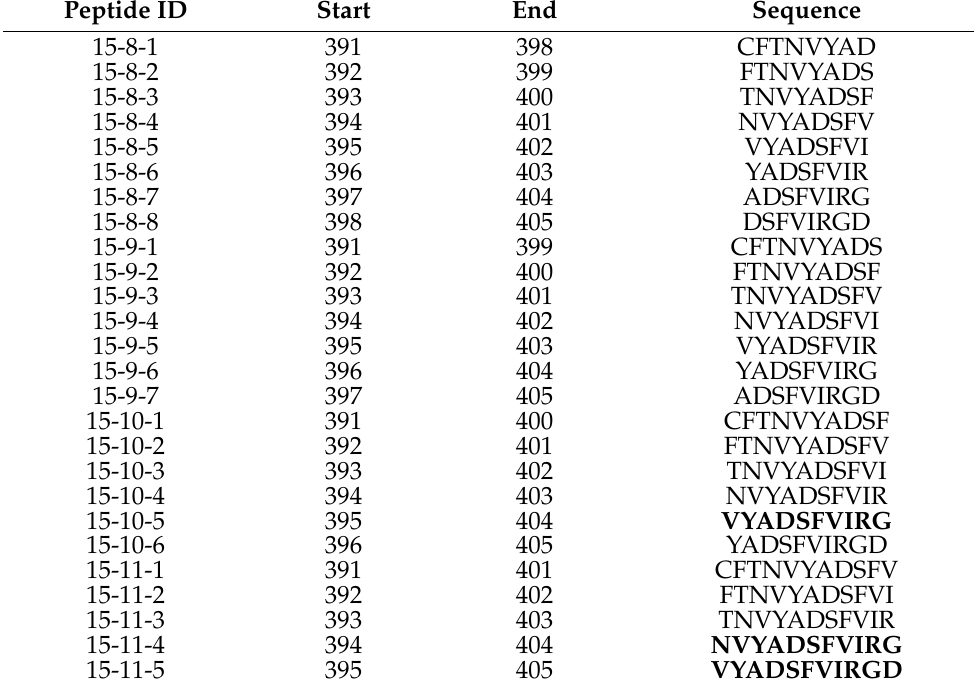
Table 2. List of tested 8–11-mer peptides within SARS-CoV-2 spike RBD 391–405